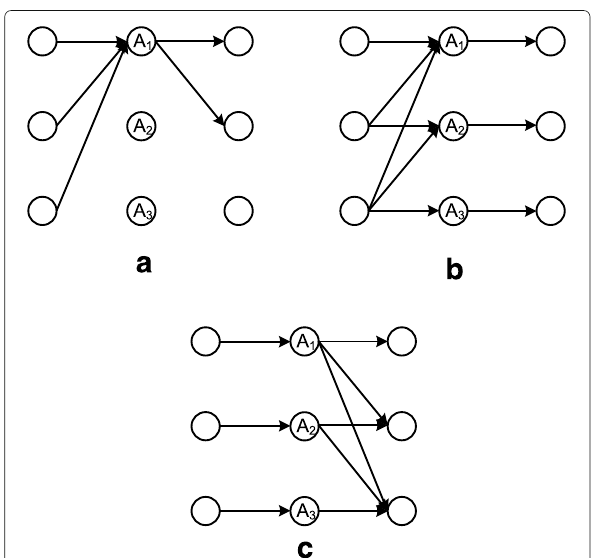
Fig. 11 a – c The normalized sum capacity of a 3 × 3 × 3 network with 1-local view, α ∗ , is equal to 1 / 3 if and only if one of the graphs in this figure is a subgraph of